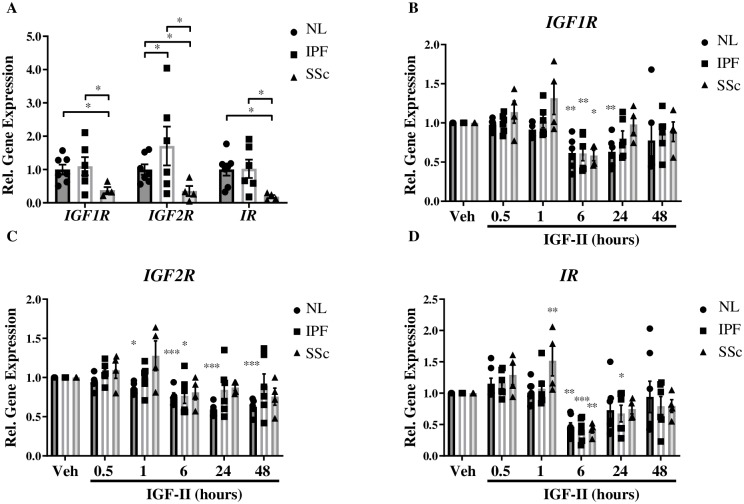
Steady-state and IGF-II-stimulated changes in receptor gene expression.Basal (A) and IGF-II (200 ng/mL)-mediated gene expression of IGF1R (B), IGF2R (C), and IR (D) receptors in Normal Lung (NL), IPF, and SSc fibroblasts normalized to GAPDH housekeeping gene. N = 3–6. *p<0.05, **p<0.01, ***p<0.001 by paired 2-tailed Student’s T Test (A) and 1-way ANOVA with Dunnett’s multiple comparison test compared to vehicle (PBS, B-D).